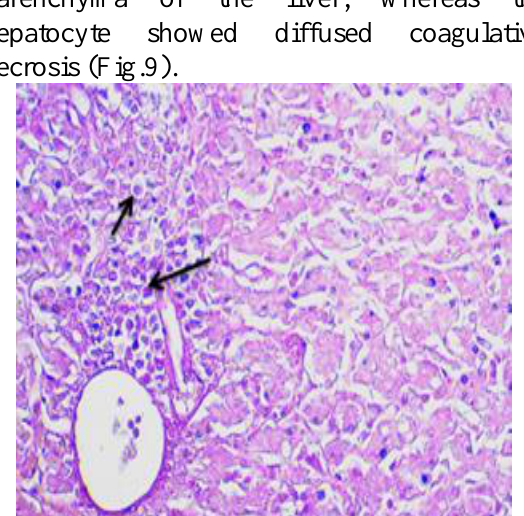
Figure,9: Chicken liver shows degeneration of hepatocytes and infiltration of lymphocytes and macrophages (black arrows) (H&E